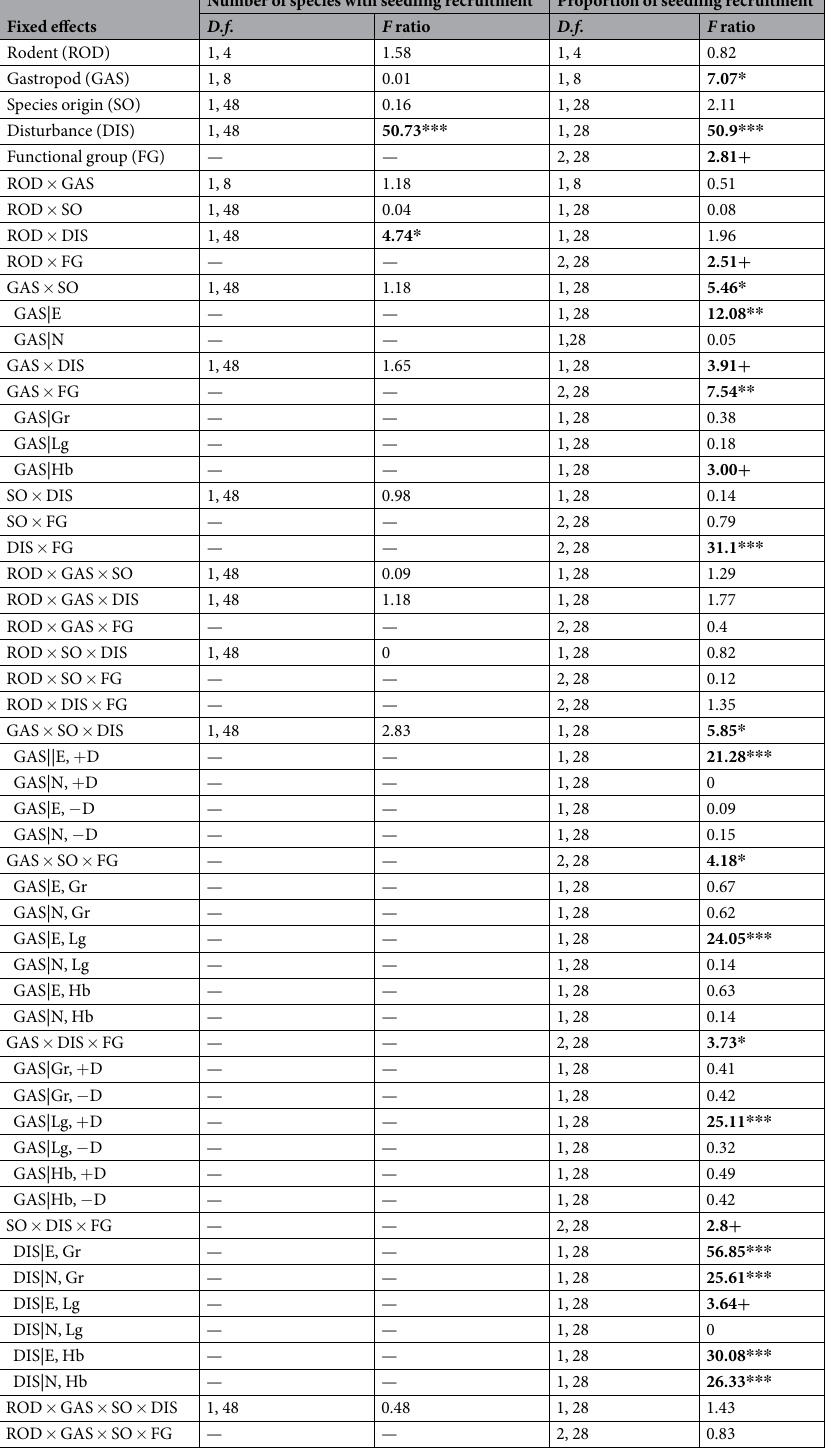
Table 1. Results of linear mixed models for the number of species with seedling recruitment and for the proportion of seedling recruitment (i.e the numbers of recruited individuals in relation to the number of added propagules per species) testing for the effects of rodent herbivory (rodent control, rodent exclusion), gastropod herbivory (gastropod control, gastropod exclusion), species origin (exotic = E, native = N), and disturbance (disturbed = + D, undisturbed = − D). Functional group (grasses = Gr, legumes = Lg, herbs = Hb) and its interactions were not included in the model for the number of species with seedling recruitment. For relevant interactions, the effect of one factors is tested for each level of the other factor or factorial combinations (simple main effects). D.f . refers to the numerator and denominator degrees of freedom. Significant F values are shown in bold: + P < 0.10, * P < 0.05, ** P < 0.01, *** P <